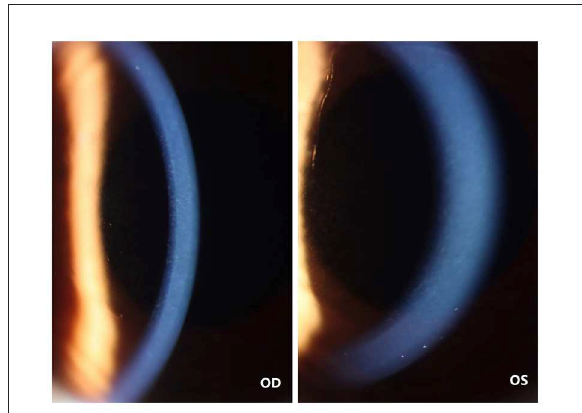
FIGURE1 Photographs of the cornea of the patient’s both eyes. The color cornea photograph the patient’s both eyes showing grayish white fine deposits between the Descemet memberane and the corneal endothelial layer.